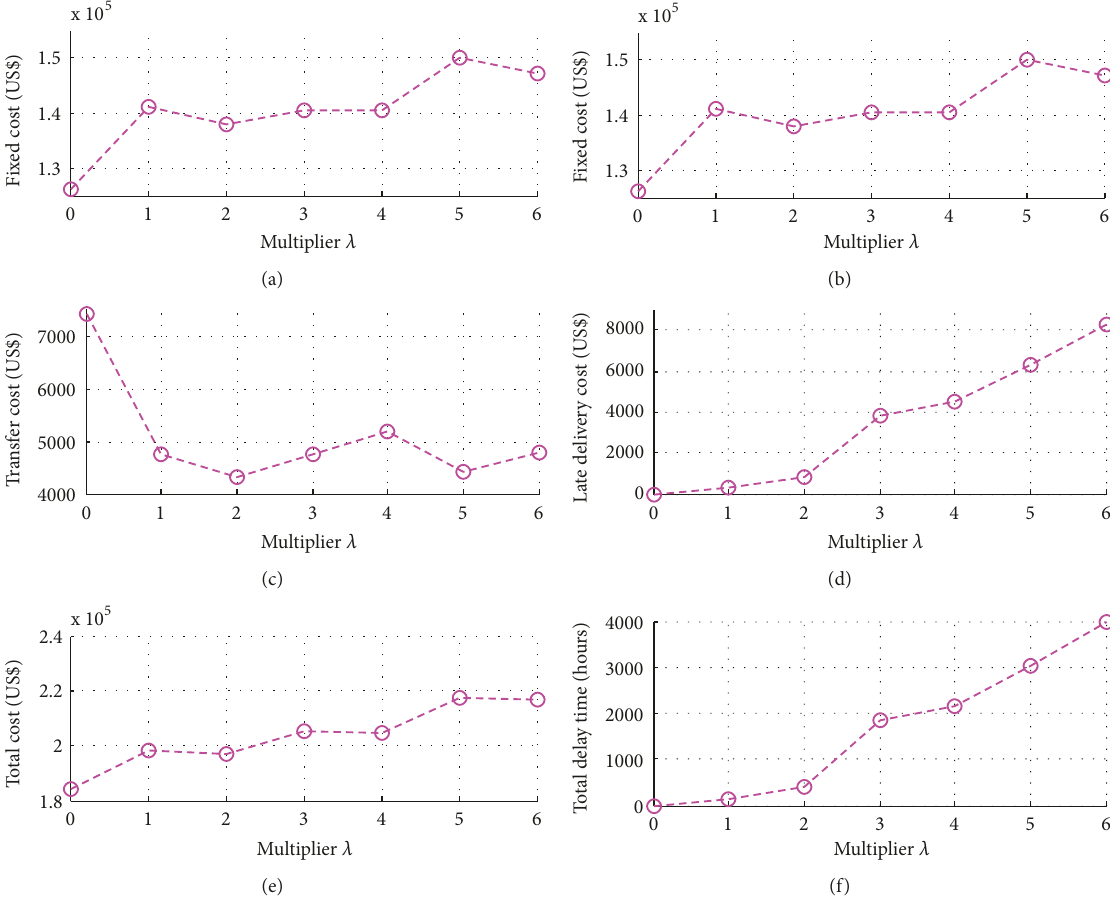
Figure 4: The costs under different multiplier 𝜆 . (a) Fixed cost with multiplier 𝜆 . (b) Variable cost with multiplier 𝜆 . (c) Transfer cost with multiplier 𝜆 . (d) Late delivery cost with multiplier 𝜆 . (e) Total cost with multiplier 𝜆 . (f) Total delay time with multiplier 𝜆 .